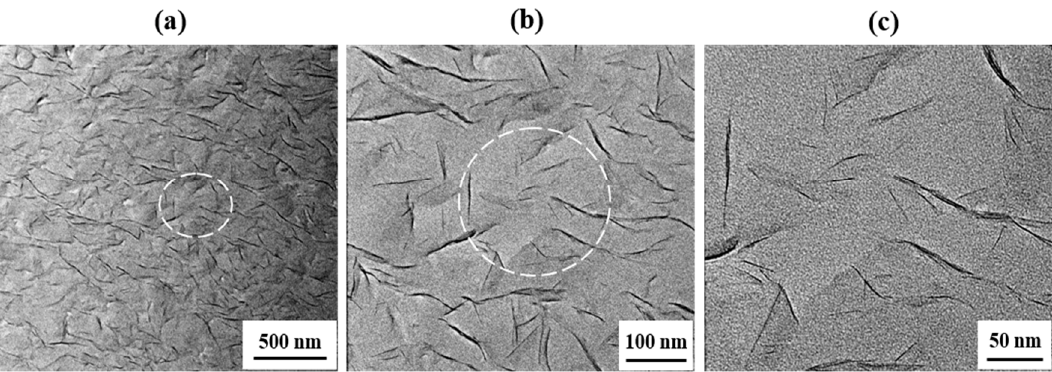
Figure 6. Transmission electron microscopy (TEM) images of the Co-PI hybrid films containing 10 wt % STN at different magnifications.